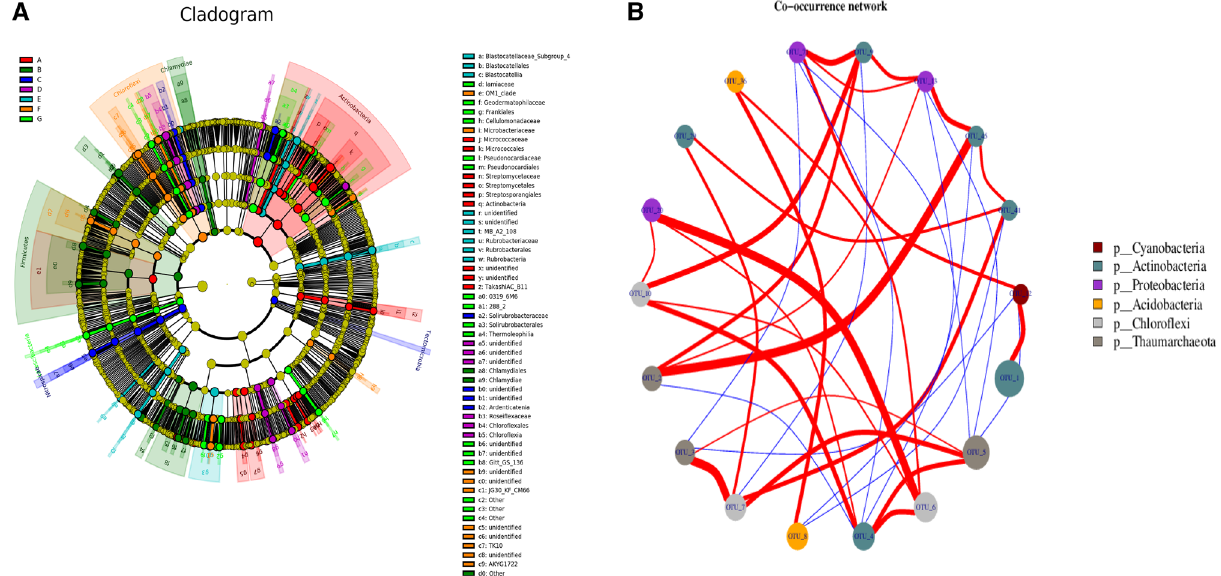
Figure 6. ( A ) The cladogram of soil rhizospheric bacteria generated by LEfSe indicating differences of taxa between treatments. The connection stands for a strong and significant occurelation. The size of each node is proportional to the relative abundance. Red, dark green, blue, purple, grass green, orange, and light green on the bacterial trees indicate the taxa that are enriched in cropping year of 5, 10, 15, 20, 25, 30 and 30 with field corn, respectively ( ɑ > 0.01). ( B ) The co-occurrence network interactions of soil rhizospheric bacteria. The connection stands for a strong and significant ocrrelation. The size of each node is proportional to the relative abundance.